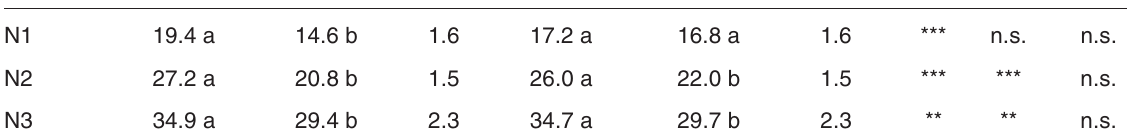
N Concentration in Shoot Dry Matter at Flowering, and in Straw and Seed Dry Matter at Maturity of Rape as Influenced by Year (Y), Cultivar (C), and N Supply Year N Supply Shoot N concentration at the beginning of flowering [mg g – 1 dry matter]